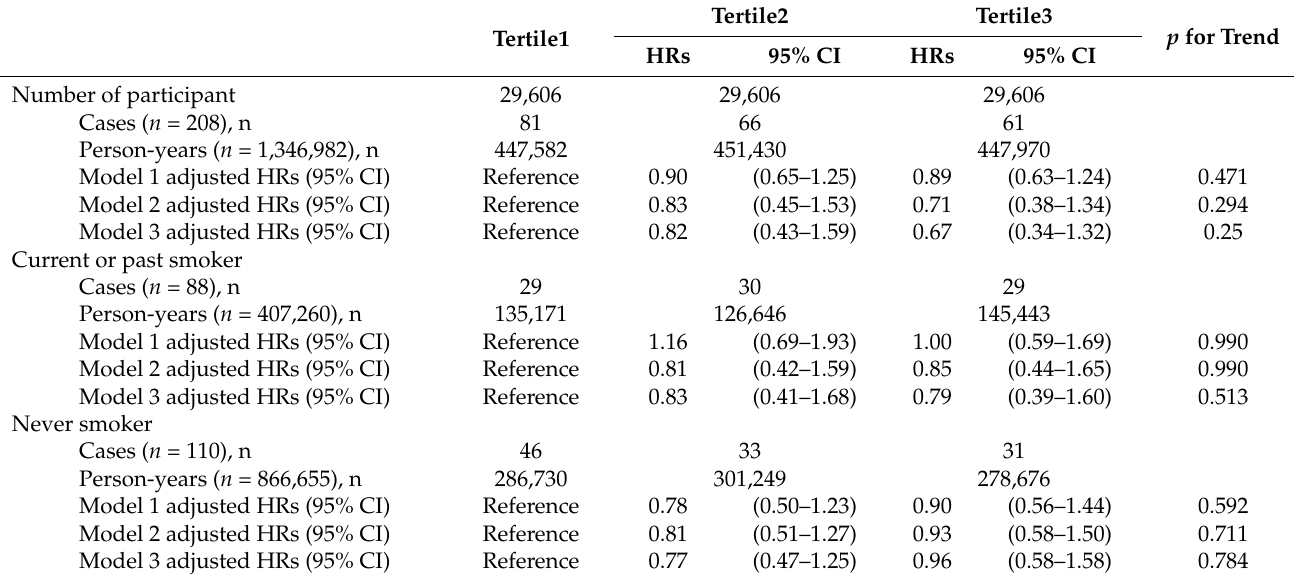
Table 2. Acrylamide intake and the risk of renal cell